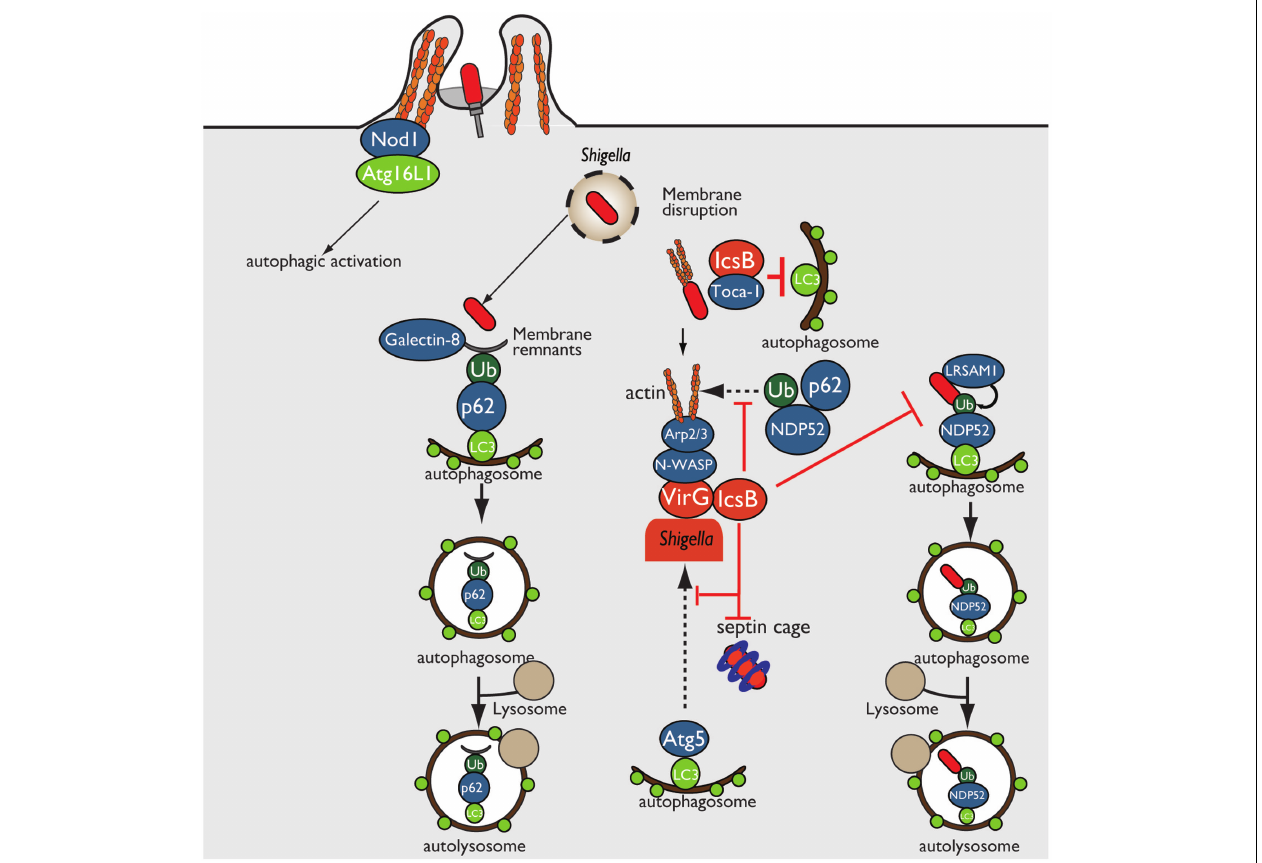
and prevents Atg5–VirG interaction and ubiquitin recruitment, thereby evading autophagic recognition. IcsB also recruits Toca-1, and prevents the recruitment of LC3 to around intracellular